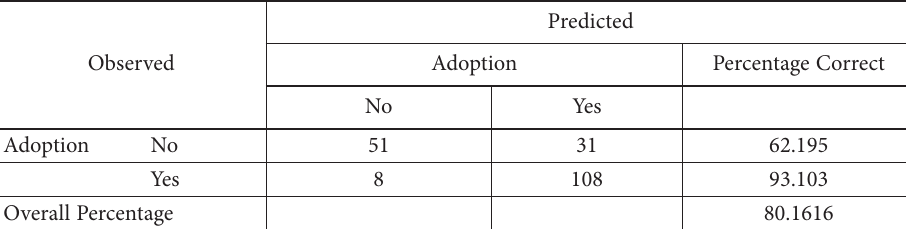
Table 16. Classification of accuracy of the researched